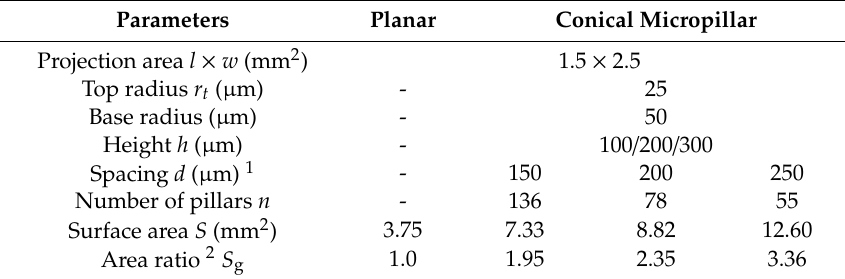
Table 1. Parameters of the working electrode for numerical